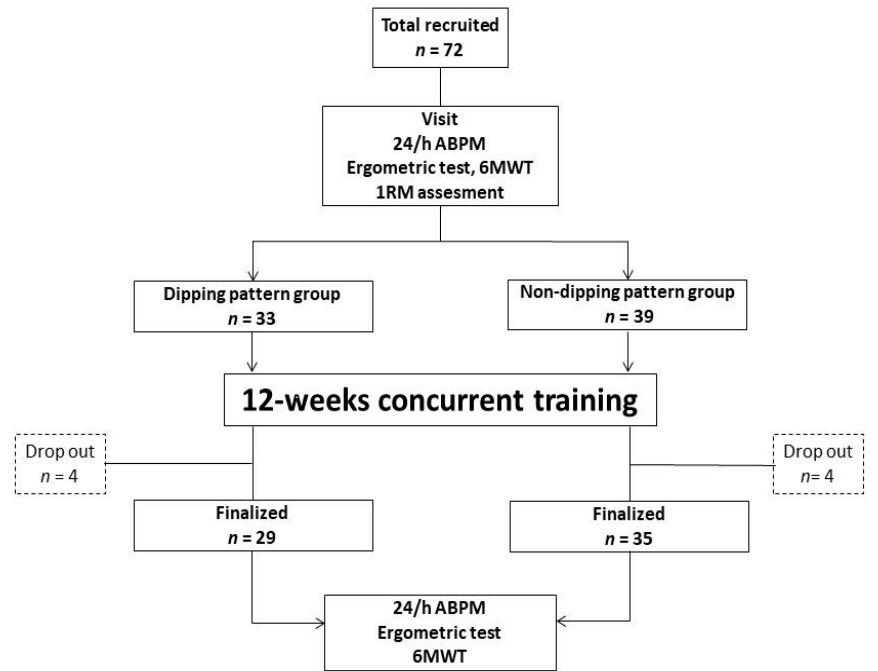
Figure 1. Study Figure 1. Study flowchart.